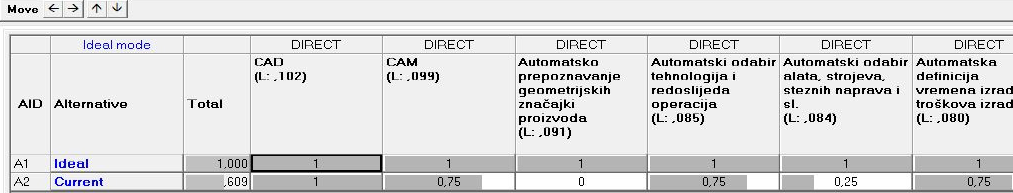
Figure 7. Single element (criterion) evaluation—model.